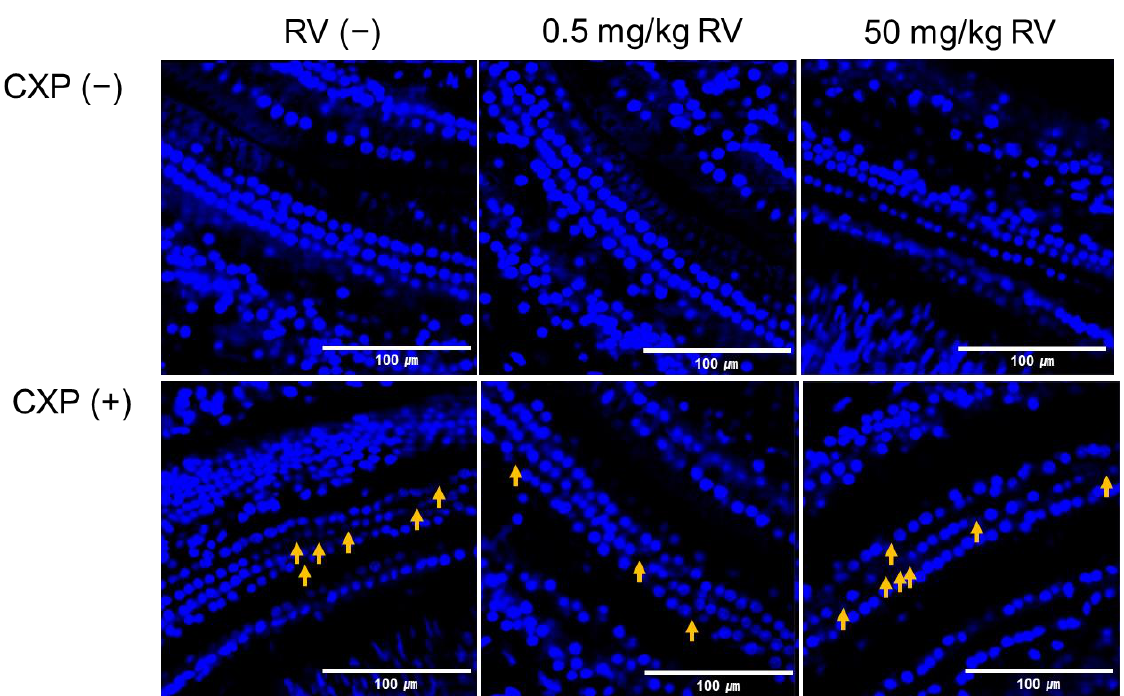
Figure 2. The loss of outer hair cells were noted in the 50 mg/kg RV group. (yellow arrow: loss of outer hair cells).